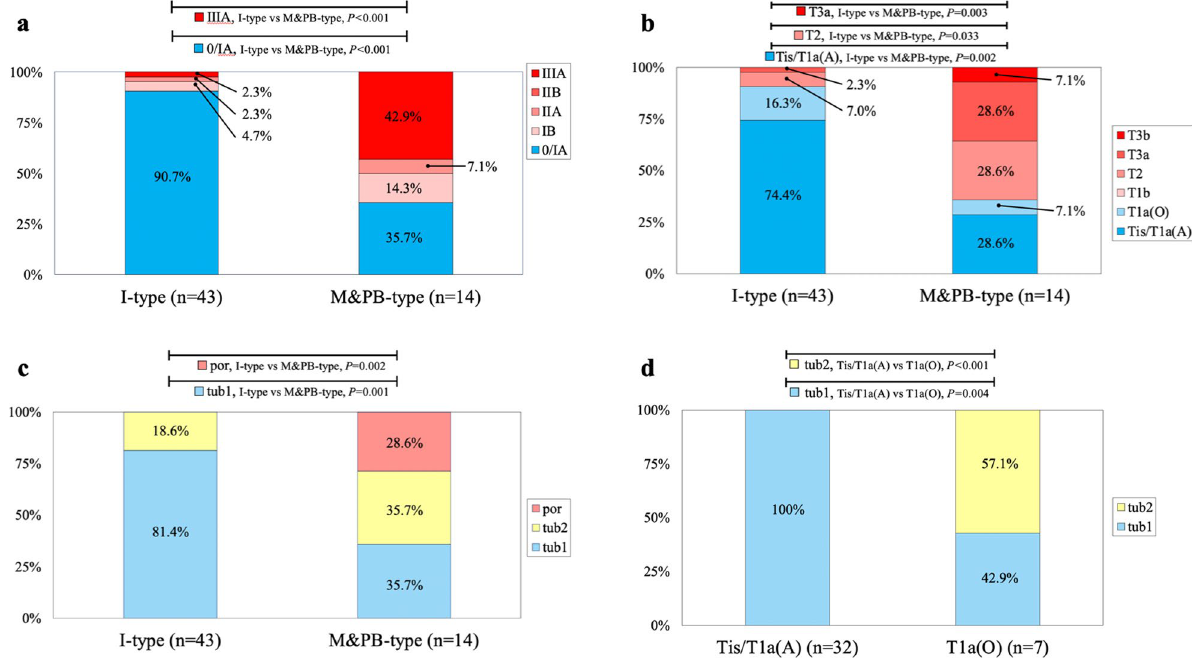
Figure 1. Comparison of overall stage, T stage of the primary tumor, and pathological grade between the intestinal-type and mixed/pancreatobiliary-type. ( a ) Overall stage. (0, TisN0M0; IA, T1aN0M0; IB, T1b/ T2N0M0; IIA, T3aN0M0; IIB, T3bN0M0; IIIA, T1a/T1b/T2/T3N1M0). There were statistically significant differences in IA ( P = 0.014) and IIIA ( P < 0.001) between the intestinal and mixed/pancreatobiliary types. There was no significant difference in 0, IB, IIA, or IIB between the intestinal and mixed/pancreatobiliary types. ( b ) T stage of the primary tumor. Tis, carcinoma in situ; T1a(A), tumor limited to ampulla of Vater; T1a(O), tumor limited to sphincter of Oddi; T2, tumor invades the muscularis propria of the duodenum; T3a, tumor invades 0.5 cm or less into the pancreas. There were significant differences in Tis and T1a(A) ( P = 0.002), T2 ( P = 0.033), and T3a ( P = 0.003) between the intestinal and mixed/pancreatobiliary types. There was no significant difference in T1a(O), T1b, or T3b between the intestinal and mixed/pancreatobiliary types. ( c ) Pathological grade. tub1, well-differentiated tubular adenocarcinoma; tub2, moderately differentiated tubular adenocarcinoma; por, poorly differentiated adenocarcinoma. There were significant differences in tub1 ( P = 0.001) and por ( P < 0.002) between the intestinal and mixed/pancreatobiliary types. There was no significant difference in tub2 between the intestinal and mixed/pancreatobiliary types. ( d ) Pathological grade of intestinal-type early AC. tub1, well- differentiated tubular adenocarcinoma; tub2, moderately differentiated tubular adenocarcinoma; Tis, carcinoma in situ; T1a(A), tumor limited to ampulla of Vater; T1a(O), tumor limited to sphincter of Oddi. There were significant differences in tub1 (100% vs 42.9%, P = 0.004) and tub2 (0% vs 57.1%, P < 0.001) between the Tis/ T1a(A) and T1a(O) Almost all I-type tumors had an overall stage of 0/IA (i.e., early AC) whereas more than half of the M&PB- type tumors were higher than stage IB (i.e., advanced AC). The 0/IA stage was significantly more common in the I-type than in the M&PB-type (90.7% vs 35.7%, P < 0.001; Fig. 1a, Supplementary Fig. S1b). I-type primary tumors had high rates of early AC whereas the M&PB-types had high rates of advanced AC. Tis/T1a(ampulla) was significantly more likely in the I-type than in the M&PB-type (74.4% vs 14.3%, P = 0.002; Fig. 1b, Supple- mentary Fig. S1c). A pathological grade of tub1 was more common in the I-type whereas tub2 and por were more common in the M&PB-type. The tub1 rate was significantly higher in the I-type than in the M&PB-type (81.4% vs 35.7%, P = 0.001; Fig. 1c, Supplementary Fig. S1d). In the I-type, the tub1 rate was significantly higher in Tis/T1a(ampulla) tumors than in T1a(Oddi) tumors (100% vs 42.9%, P = 0.004; Fig. 1d). None of the Tis/T1a(ampulla) samples showed lymphovascular or perineural invasion and none of the Tis/ T1a(ampulla) or T1a(Oddi) samples had lymph node metastases (Fig. 2). Concordance between endoscopic biopsy and resected specimens for tumor diagnosis. There was high diagnostic concordance between the specimens obtained by endoscopic biopsy and specimens resected by endoscopic papillectomy or surgery in terms of pathological subtype (κ = 0.805; 95% confidence interval [CI], 0.55–1.06, P < 0.001) and pathological grade (κ = 0.645; 95% CI 0.30–0.99, P = 0.001; Table 2, Supplementary Table S2).